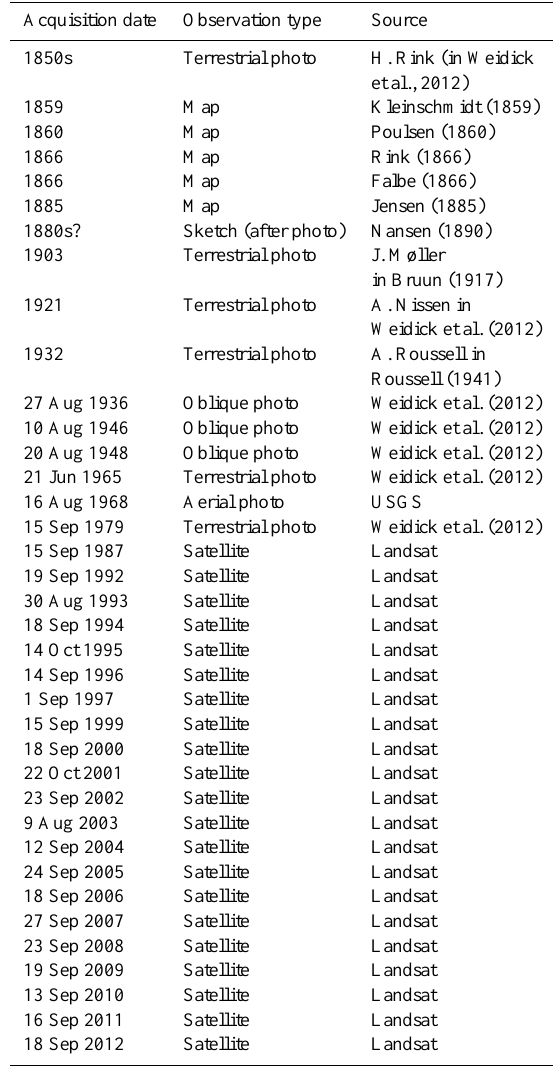
Table 1. List of terminus observations and acquisition